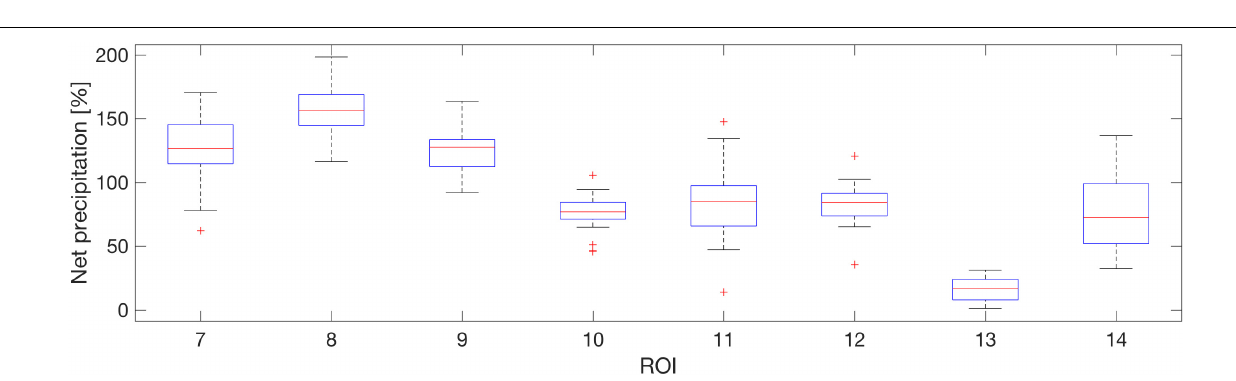
FIGURE 8 | Boxplot of the proportion of net precipitation from rainfall in percent. The boxplots show the variability over time (1992–2014). Only ROIs (7–14) for which gridded rainfall was available are